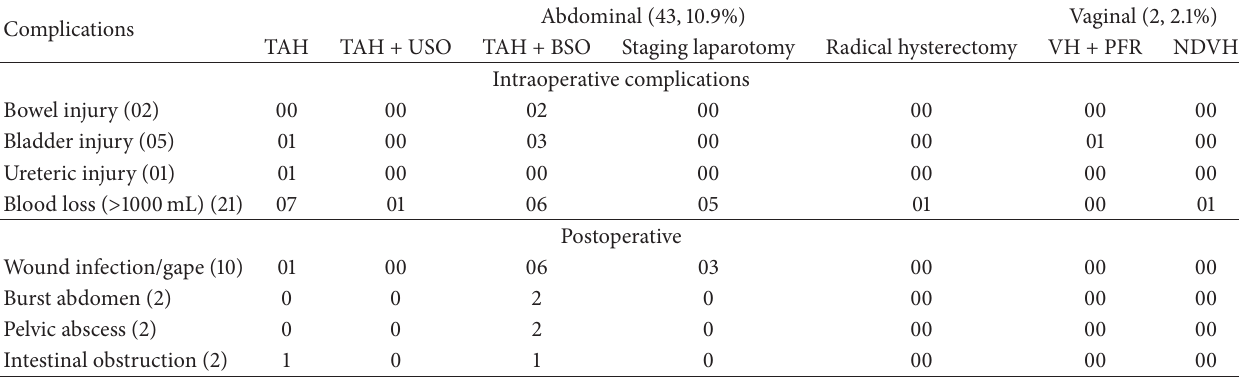
Table 4: Complications of hysterectomy in relation to the